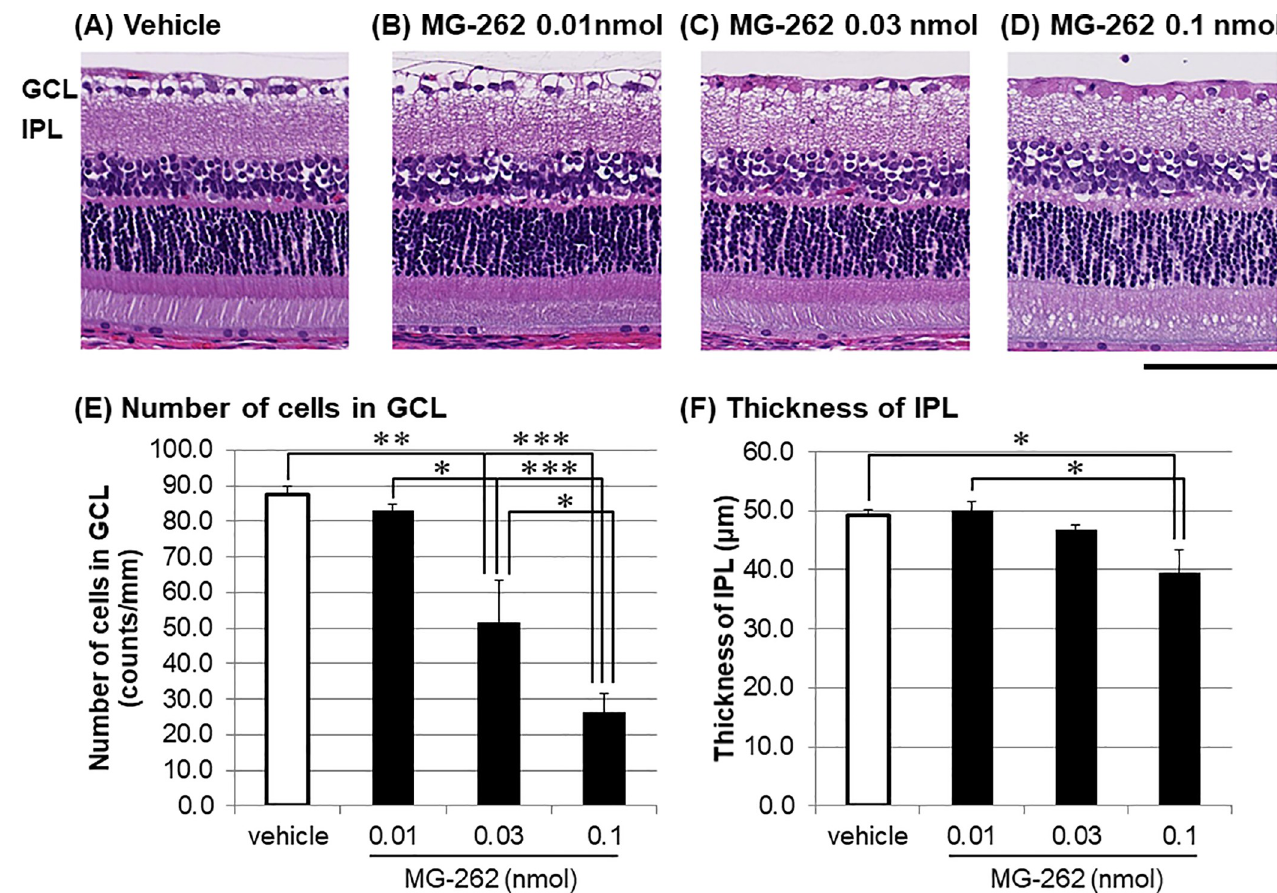
Fig 2. Dose-dependency of retinal degeneration induced by MG-262 in the normal adult rat eyes. Each photograph shows the representative image of cross- sectioned retina 7 days following intravitreal injection of vehicle (A, 10% DMSO in D-PBS) and various concentrations of MG-262 (B: 0.01 nmol/eye; C: 0.03 nmol/eye; D: 0.1 nmol/eye). The scale bar shows 100 μ m. The lower left and right panels show the number of cells in the ganglion cell layer (GCL, E) and the thickness of the inner plexiform layer (IPL, F), respectively. Each value represents the mean ± S.E.M. of 3 to 4 eyes from 2 to 3 animals. � P < 0.05; �� P < 0.01; ��� P < 0.001, by Tukey’s multiple comparison